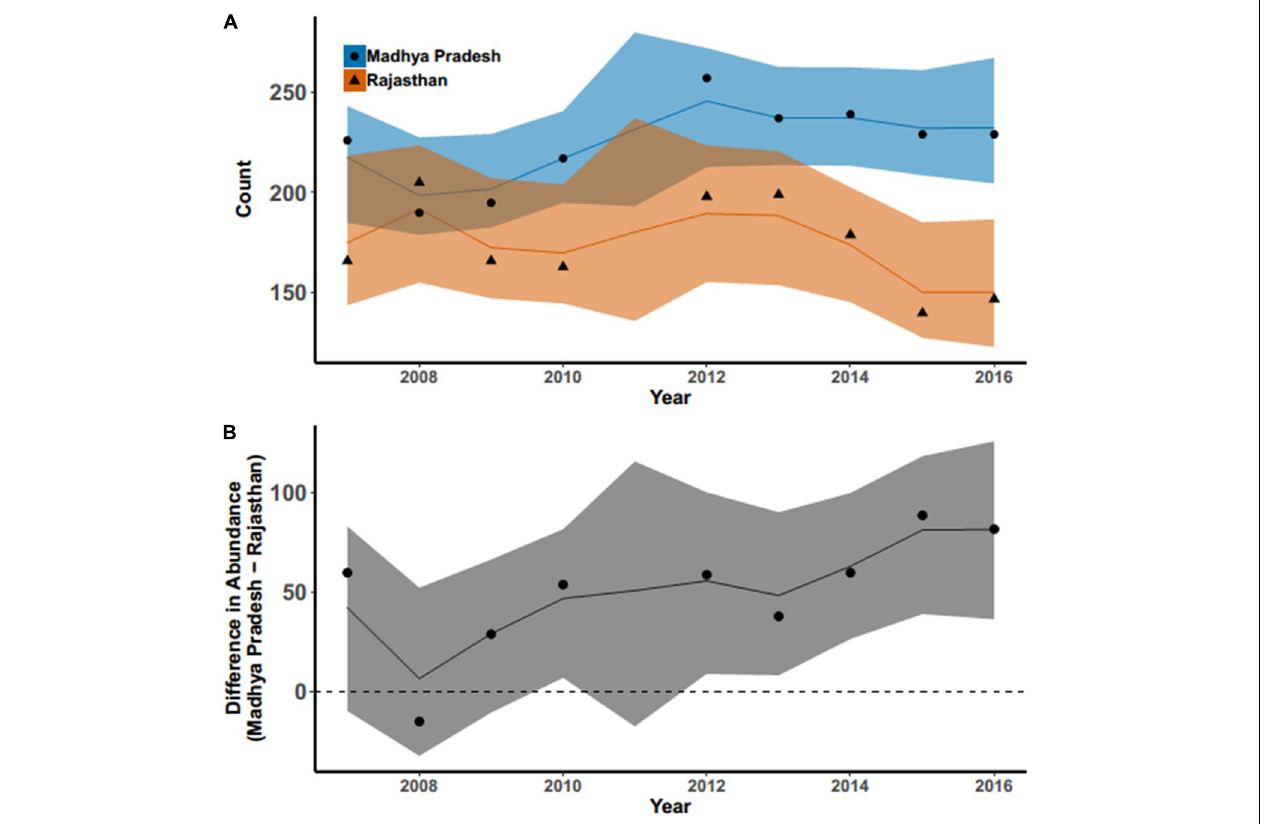
FIGURE 2 | (A) Observed (points) and estimated (lines, shaded areas = 95% CRIs) counts of occupied Indian Vulture nests within the Indian states of Madhya Pradesh (circles, blue) and Rajasthan (triangles, orange). (B) Observed (points) and estimated (line, shaded area = 95% CRIs) differences between yearly counts of occupied Indian Vulture nests within study sites in the eastern portions of the Indian states of Madhya Pradesh and Rajasthan. The dashed line at zero represents no difference between the two